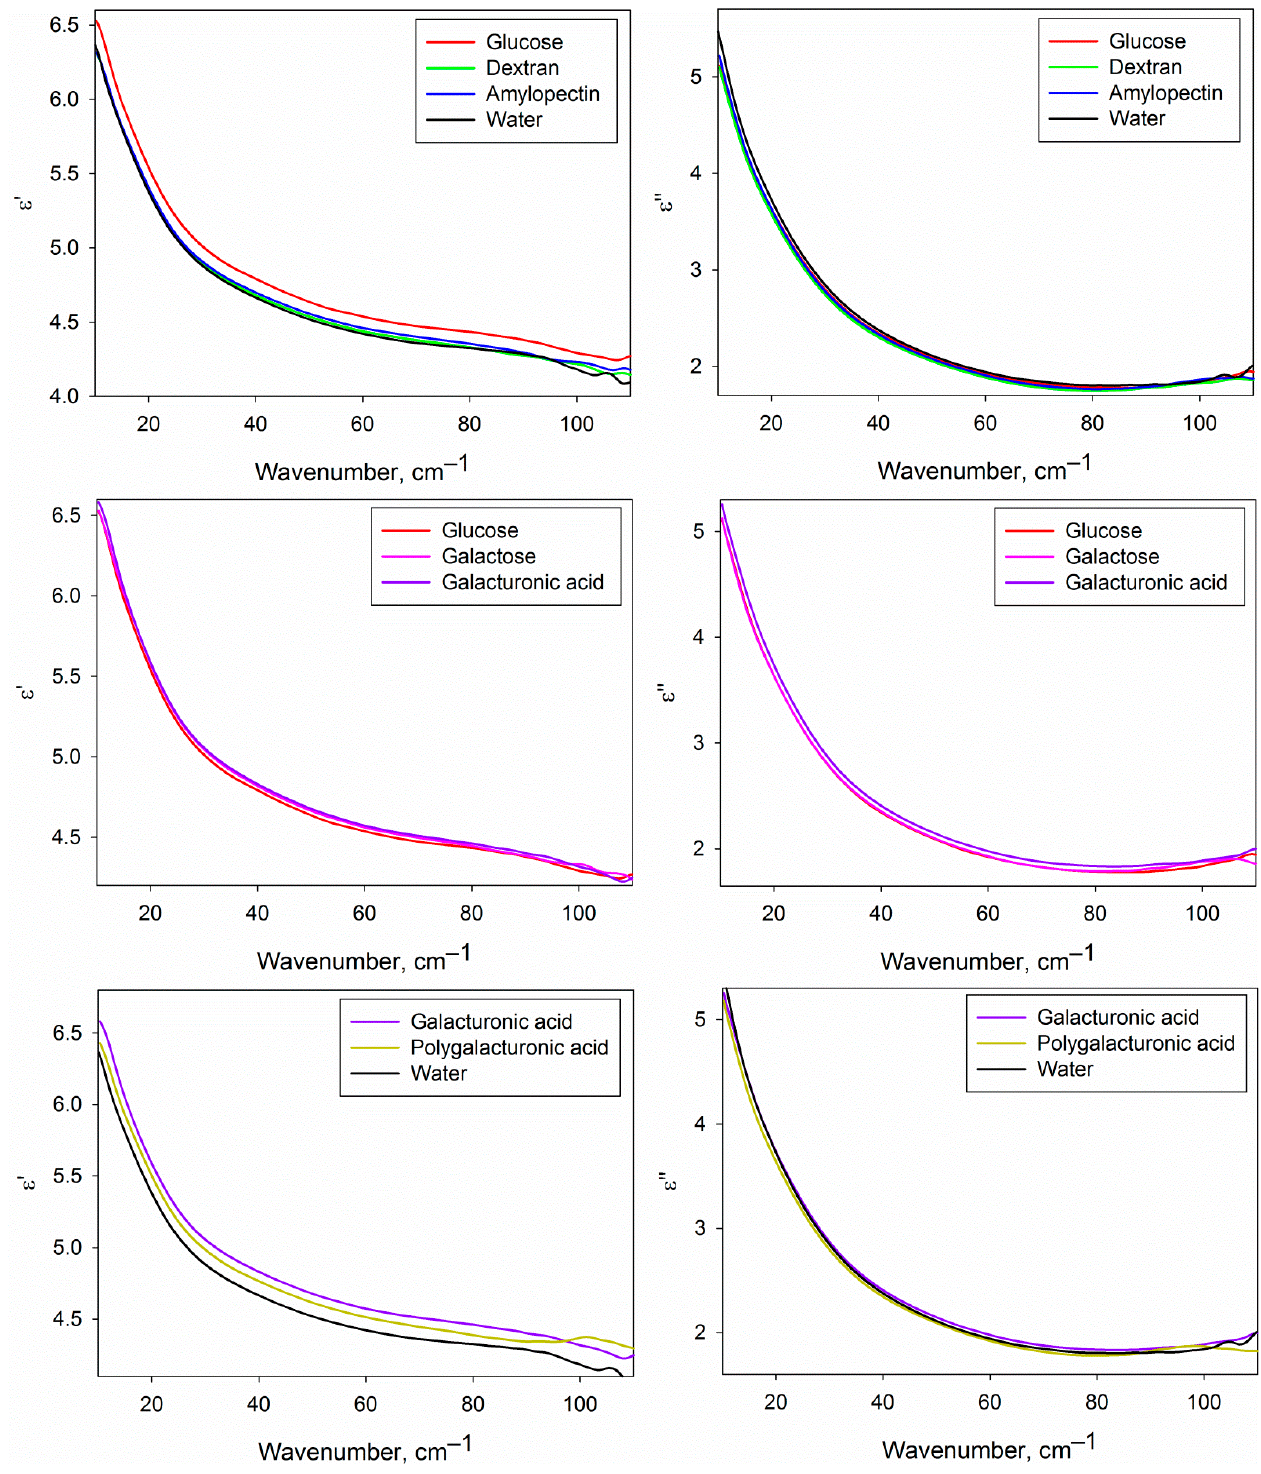
Figure 4. Dielectric permittivities (real 𝜀′ and imaginary 𝜀′′ parts) of the water phase of the studied carbohydrate solutions compared to each other and to water.